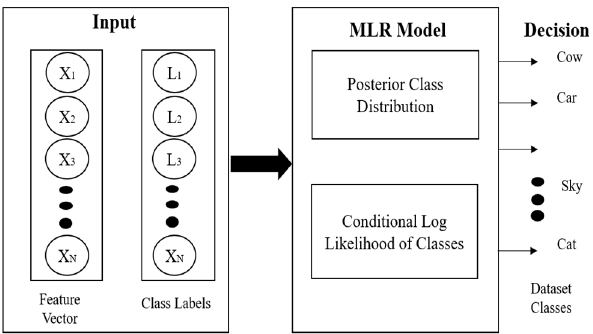
Figure 10. Flow architecture of multi-class logistic regression.